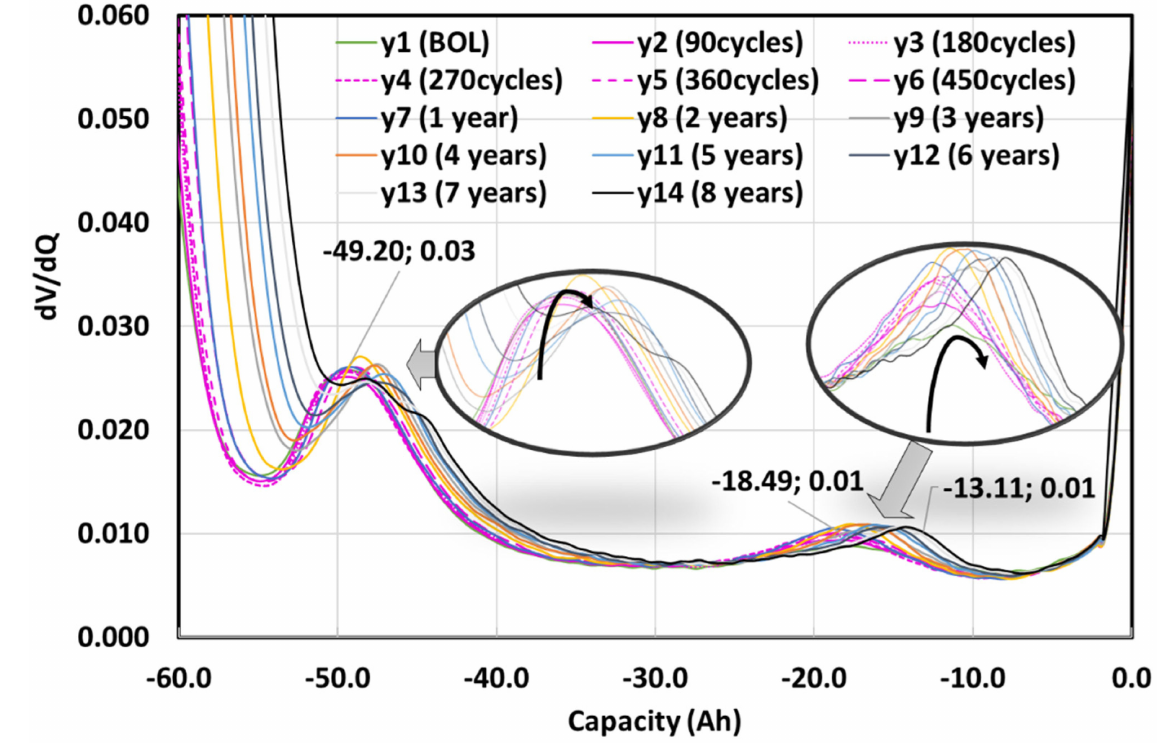
Figure 12. Evolution of DV profiles as an effect of driving cycle ageing.